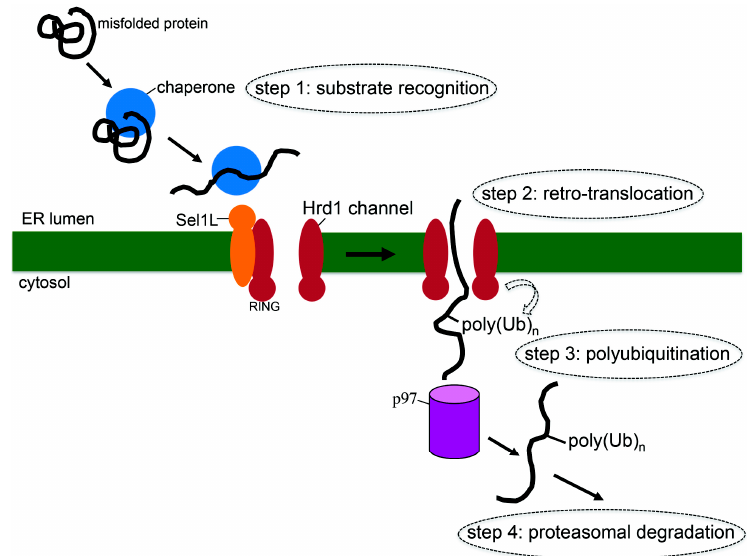
Figure 2. ER-associated degradation (ERAD) pathway. ERAD is an ER quality control pathway that identifies and triages misfolded ER proteins. In the first step, a misfolded protein is recognized by ER-resident chaperones, which target the misfolded client to the retro-translocation machinery on the ER membrane (step 1). Next the misfolded client is retro-translocated across the ER membrane by crossing the retro-translocation channel (step 2); a major component of this channel is the Sel1L-Hrd1 membrane complex. When the client emerges into the cytosol, it is ubiquitinated by the catalytic domain of Hrd1 that faces the cytosol, eventually resulting in polyubiquitinaton of the substrate (step 3). In the final step, the client is extracted into the cytosol by p97 (and its cofactors), and delivered to the proteasome for degradation (step 4). Sel1L: protein sel-1 homolog 1; Hrd1: E3 ubiquitin-protein ligase synoviolin; Poly(Ub) n : polyubiquitin chain; RING: Really Interesting New Gene finger